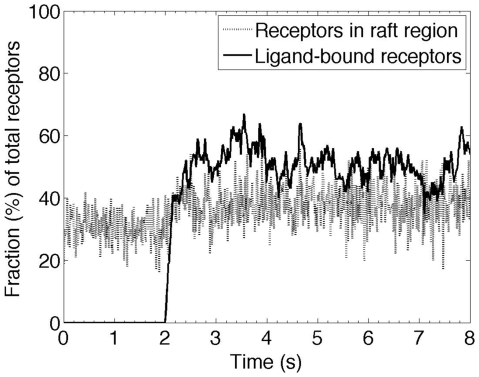
Rapid ligand-induced localization of receptors within lipid rafts due to a ligand-induced change in dimerization kinetics of receptors.Simulation was initiated with randomly distributed receptors on the membrane. Receptors were allowed to equilibrate between monomer and dimer states in the absence of ligand with kmono = 106 s−1 and kdimer = 106 s−1. Ligand with concentration [L] = Kd = kr/kf was then added and simulations continued until a steady state was reached; kf = 108 M−1s−1 and kr = 1 s−1. Ligand-bound receptors were assumed to have the same monomerization rate constant as the unligated state but kdimer was decreased to 104 s−1. Simulations were run on a membrane including lipid rafts with total area of 10% and diameter of 20 nm. Diffusion coefficients in lipid raft and non-raft regions were 10−11 cm2/s and 10−10 cm2/s respectively.